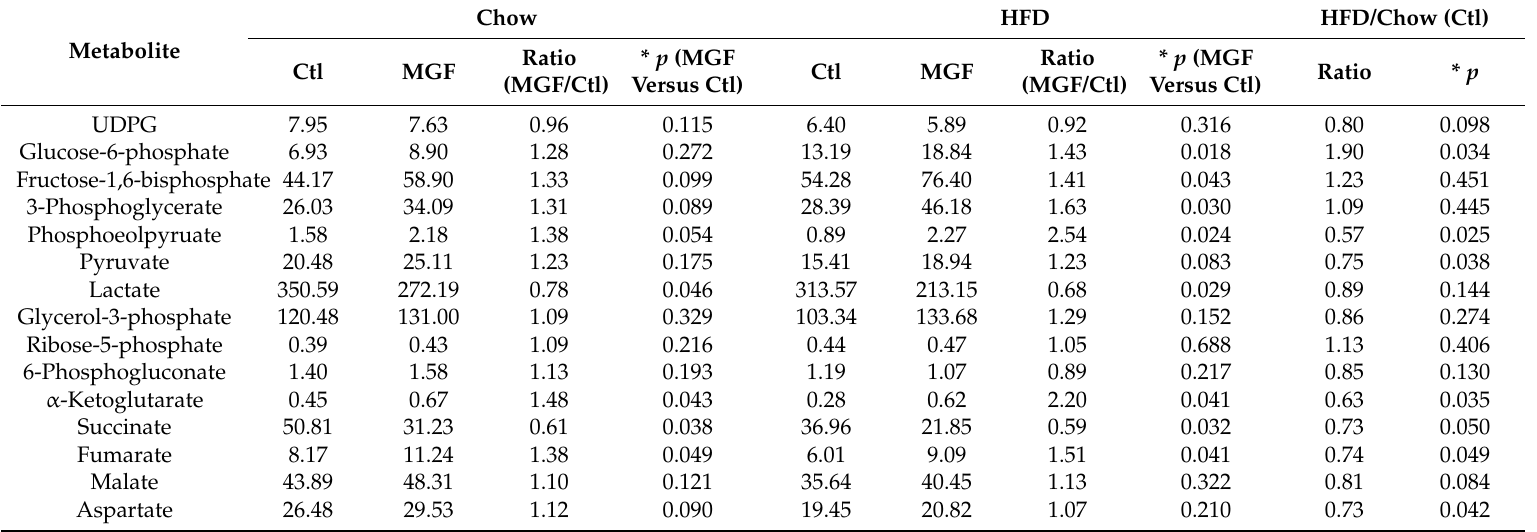
Table 1. Profiles of metabolites in quadriceps of